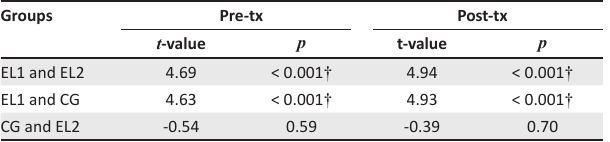
TABLE 8: Results of t -tests for significant differences in reading scores between groups.